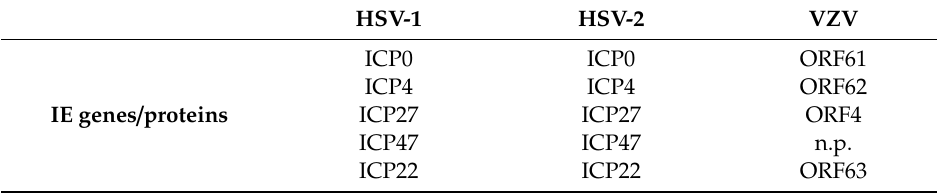
Table 2. IE genes / proteins (they maintain the same name) in the three Alphaherpesviruses . The proteins of each single virus can complement the relative homologue of the other two classes. The only exception is Varicella Zoster Virus-Open Reading Frame 4 (VZV-ORF4), which cannot entirely substitute for HSV-1 / HSV-2 ICP27